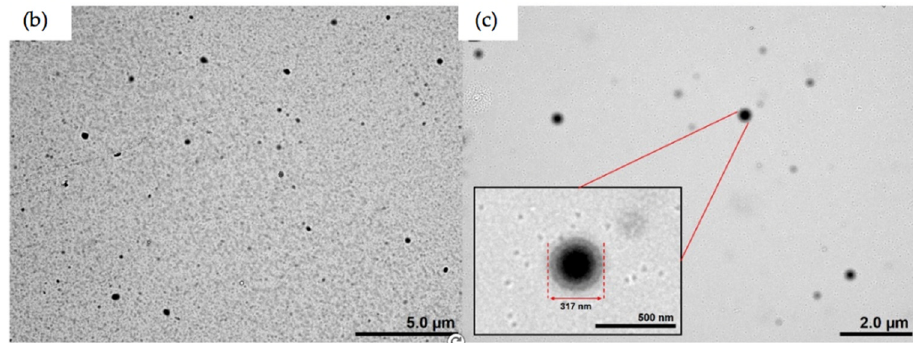
Figure 2. DLS results of size/zeta potential pattern of ( a ) GE, GEH+, and GEH − NPs; and photos of TEM acquired from ( b ) GE and ( c ) GEH − NPs.